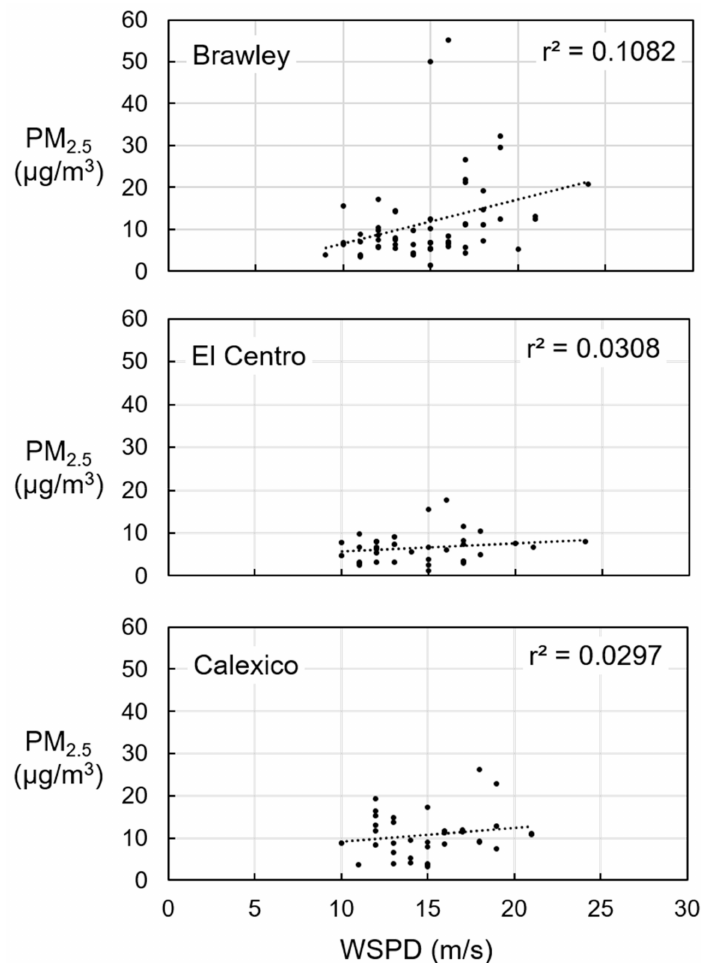
Figure 5. Daily averaged gravimetric PM2.5 concentrations versus daily-averaged wind speed at KIPL for selected springtime WSW wind events in the Imperial Valley. The coe ffi cient of determination (r 2 ) of the plotted best-fit regression line is indicated on each panel. Data comprise 57 daily events between 2013 and 2019 at Brawley, and 55 daily events between 2013 and 2019 for Calexico and El Centro. Criteria of event selection is given in Section